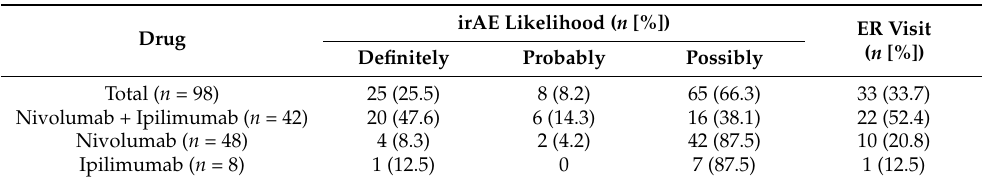
Table 2. Total immune-related adverse events in patients receiving nivolumab plus ipilimumab, nivolumab, or ipilimumab, categorized by likelihood and emergency room